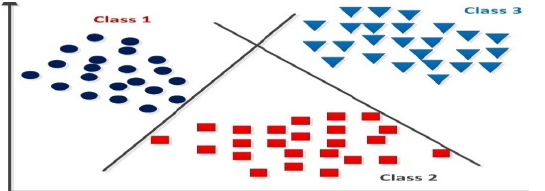
Fig. 6: Conventional LDA Model for HPCR System